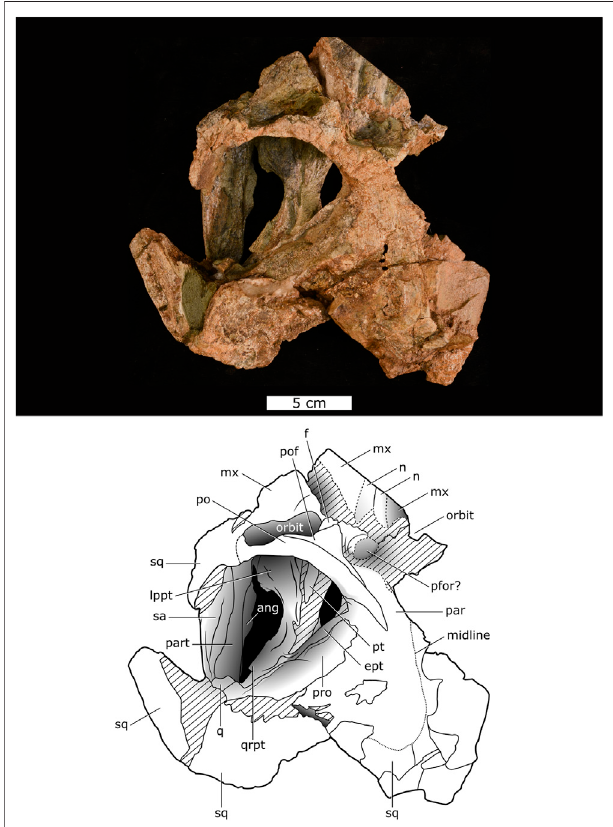
FIGURE 2 | Dorsal view of Lanthanostegus specimen